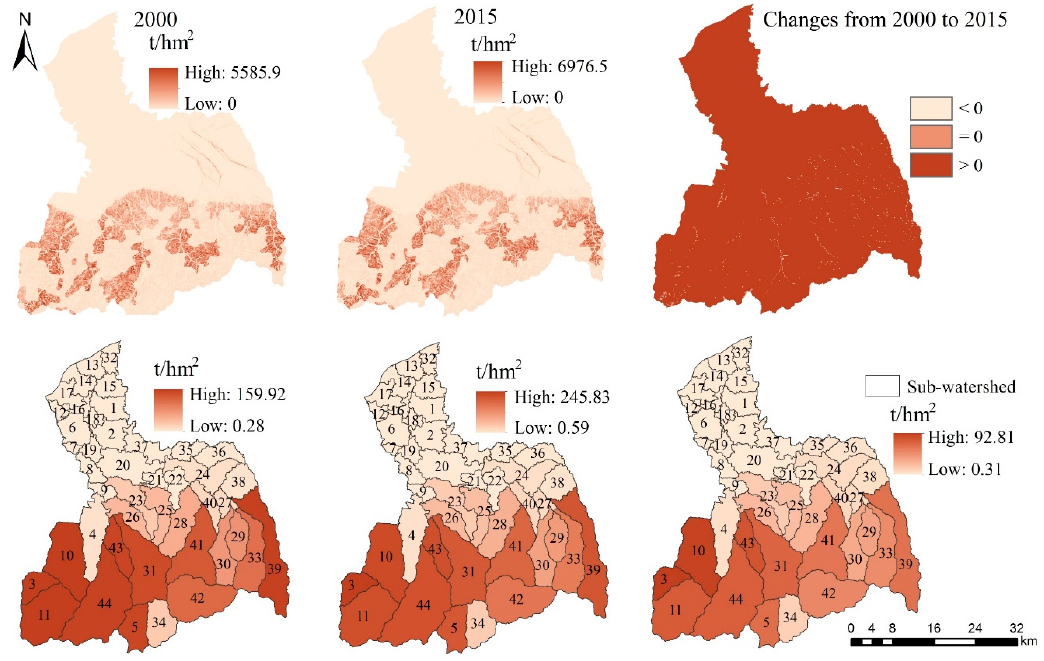
Figure 5. The spatial distribution and spatial–temporal changes of soil retention. Int. J. Environ. Res. Public Health 2020 , 17 , x FOR PEER REVIEW